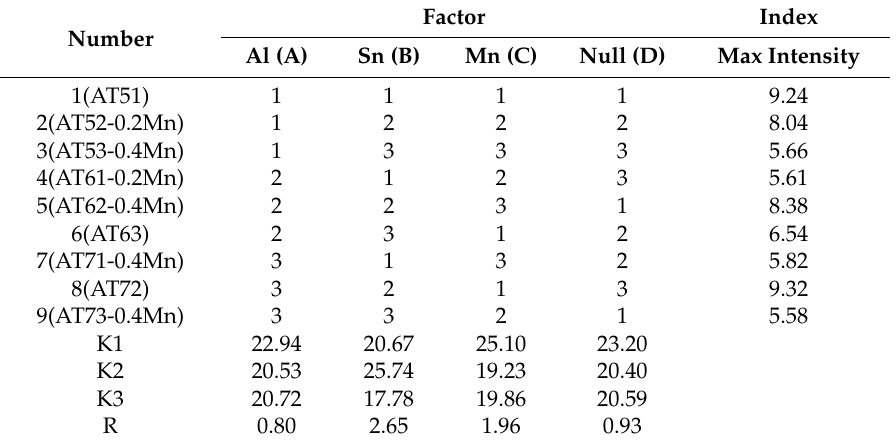
Table 2. Orthogonal test parameters and results analysis table under the maximum texture intensity